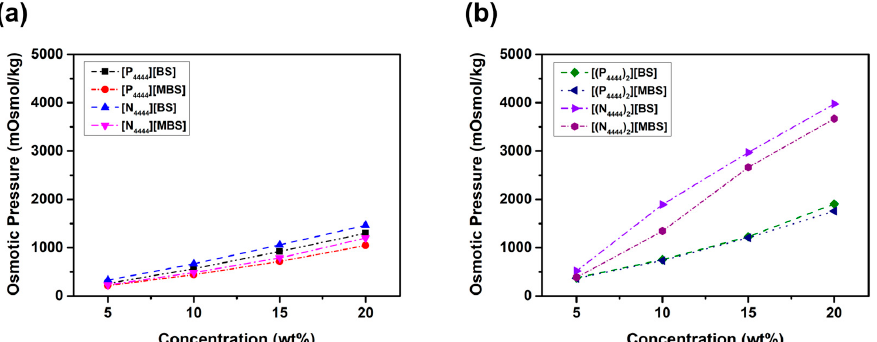
Figure 6. Osmotic pressure according to the concentration of ( a ) [P 4444 ][BS], [N 4444 ][BS], [P 4444 ][MBS], and [N 4444 ][MBS], ( b ) [(P 4444 ) 2 ][BS], [(N 4444 ) 2 ][BS], [(P 4444 ) 2 ][MBS], and [(N 4444 ) 2 ][MBS] measured by freezing point depression method.